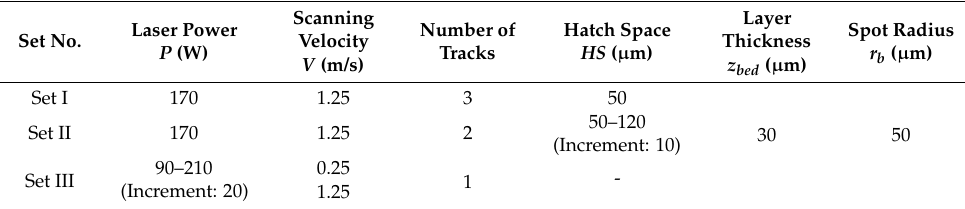
Table 2. FEM process parameters.